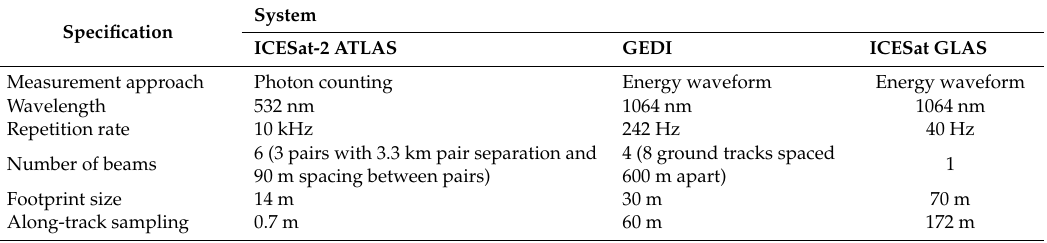
Table 2. Comparison of the ATLAS aboard ICESat-2 to the GEDI aboard the International Space Station (ISS) and the Geoscience Laser Altimeter System (GLAS) aboard ICESat [15,29]. System Specification ICESat-2 ATLAS GEDI ICESat GLAS Measurement approach Photon counting Energy waveform Energy waveform Wavelength 532 nm 1064 nm 6 (3 pairs with 3.3 km pair separation and 4 (8 ground tracks spaced Number of beams 90 m spacing between pairs) 600 m